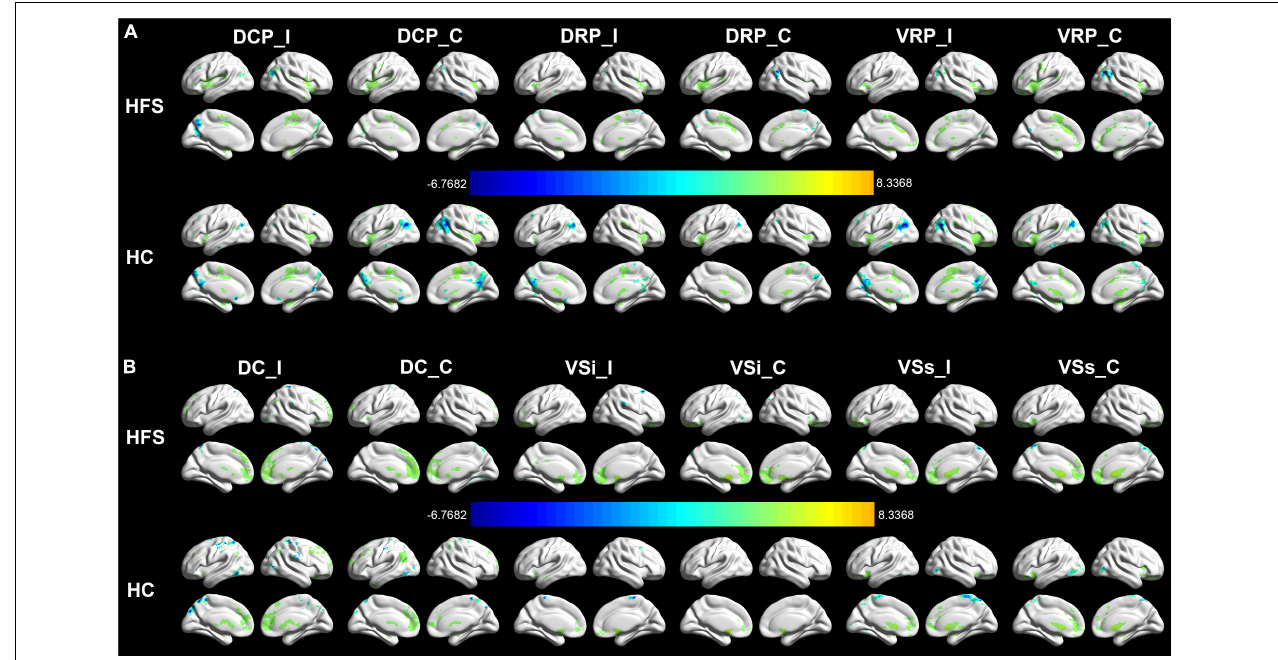
FIGURE 2 | Intragroup FC in the cortical-striatal network. The FC maps of the cortical-striatal network in the HC group and HFS group were similar (AlphaSim correction, P < 0.001, cluster size > 6 mm 3 ). (A) The putamen ROIs had strengthened connectivity with the insula, MCC, precuneus, and SMA. (B) The dorsal caudate ROIs had strengthened connectivity with the ACC and SFG. The ventral striatum ROIs had strengthened connectivity with ACC and OFC. The color bar represents the t value. FC, functional connectivity; HC, healthy control; HFS, hemifacial spasm; MCC, middle cingulate cortex; SMA, supplementary motor area; ACC, anterior cingulate cortex; SFG, superior frontal gyrus; OFC, orbitofrontal cortex; I, ipsilateral; C, contralateral; DCP, dorsal caudal putamen; DRP, dorsal rostral putamen; VRP, ventral rostral putamen; DC, dorsal caudate; VSi, inferior ventral striatum; VSs, superior ventral